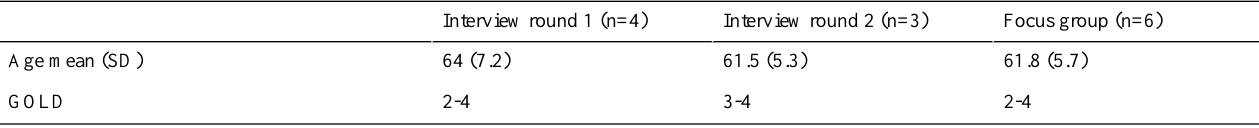
Table 2. Characteristics of respondents with COPD from the interviews and focus